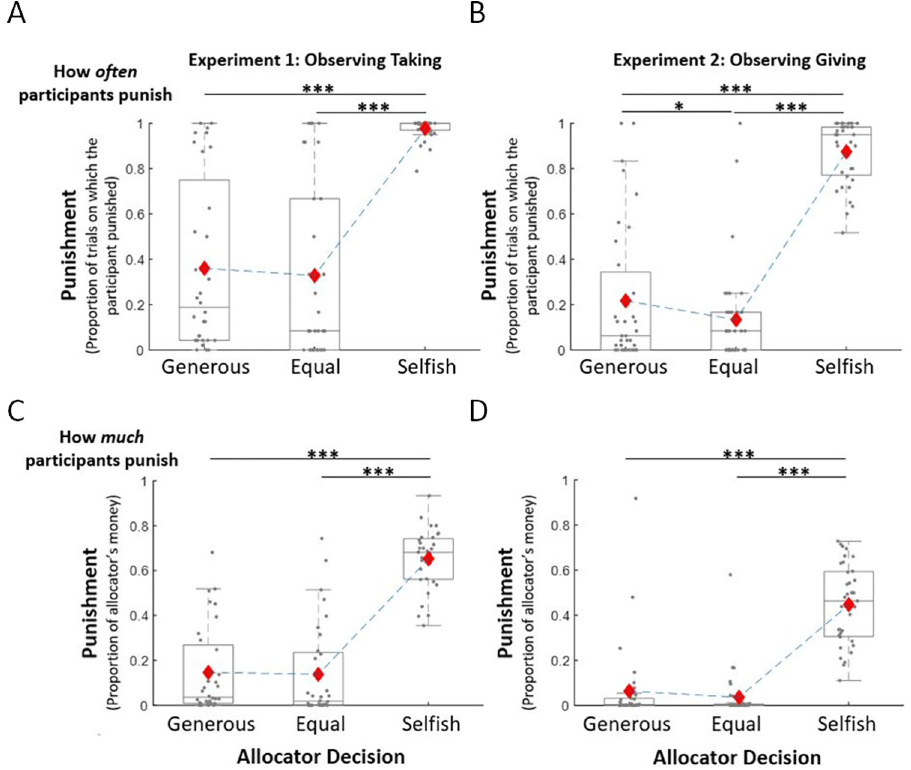
Fig 6. Observers’ Punishment. Participants punished selfish allocators more often (A & B) and more severely (C & D) than generous allocators and those who split resources equally in both Experiment 1 (A & C) and Experiment 2 (B & D). Surprisingly, participants also punished generous allocators more frequently than allocators who split the money equally in Experiment 2 (B & D) and punished them the same in Experiment 1 (A & C). Grey dots show the proportion of trials on which each participant punished each allocator (top panels) and the mean amount of punishment per allocator for each participant (bottom panels). Red diamonds represent the averages of these means. The box plots show the distribution of the participants’ mean punishment per allocator: boxes indicate 25–75% interquartile range, whiskers extend from the first and third quartiles to the most extreme data point within 1.5 × interquartile range, and the median is shown as a horizontal line within this box. � p < 0.05, ��� p <